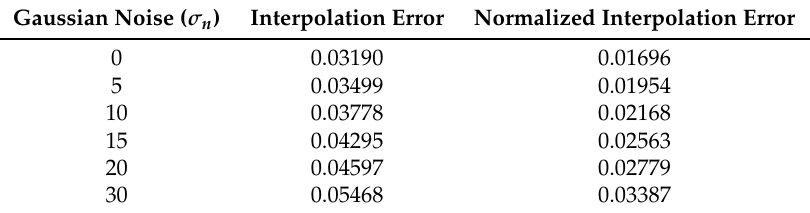
Table 4. Interpolation Error and Normalized Interpolation Error computed for a cardiac volume with several standard deviations σ n of Gaussian